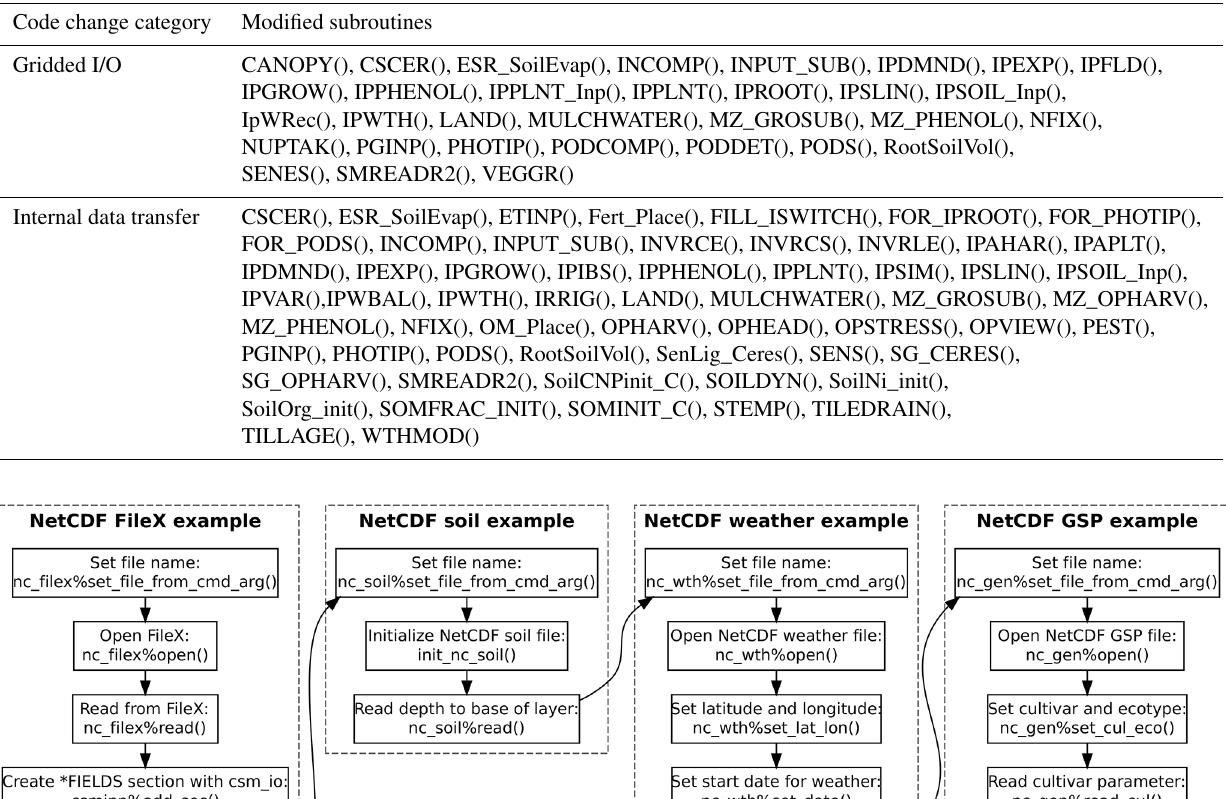
Table 1. Subroutines modified in the development of the parallel gridded version (PG) of the Decision Support System for Agrotechnology Transfer Cropping Systems Model (DSSAT-CSM). Subroutines are listed according to category of code change: internal data transfer, gridded input and output (gridded I/O).